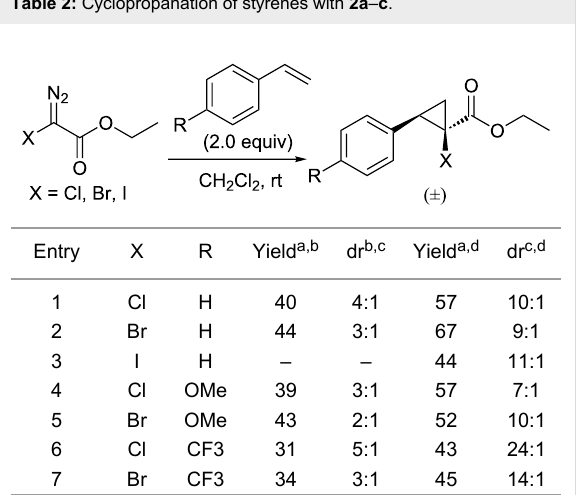
Table 2: Cyclopropanation of styrenes with 2a – c